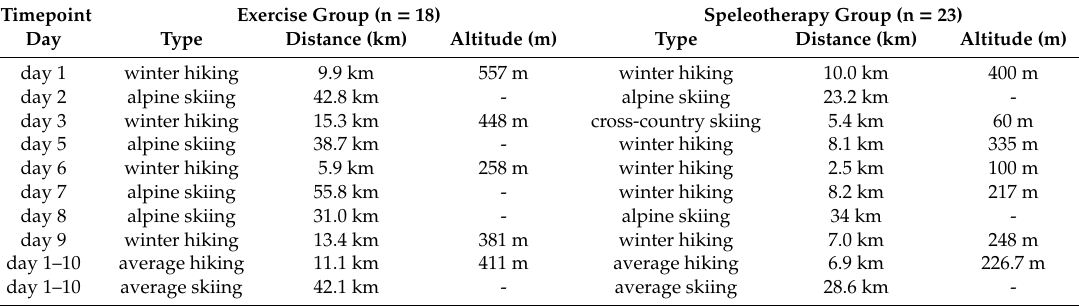
Table 2. Characteristics of the exercise